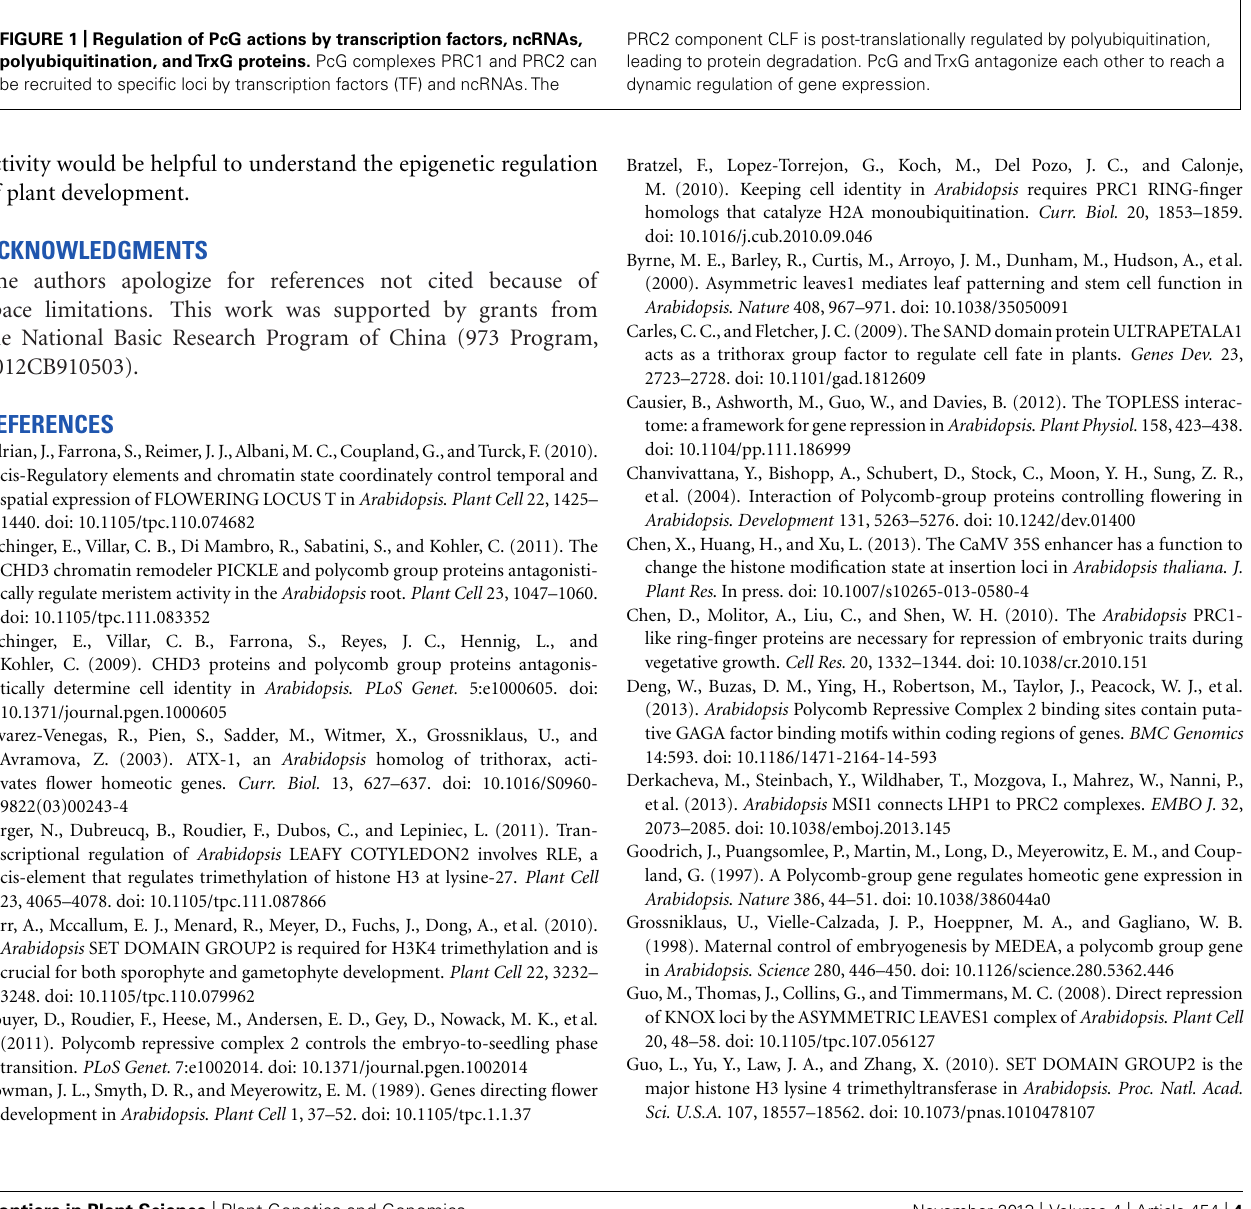
FIGURE 1 | Regulation of PcG actions by transcription factors, ncRNAs, polyubiquitination, andTrxG proteins. PcG complexes PRC1 and PRC2 can be recruited to specific loci by transcription factors (TF) and ncRNAs.The